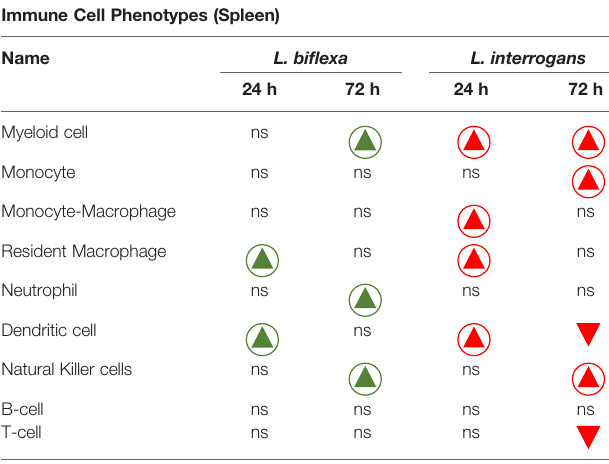
TABLE 3 | Immune cells engaged during infection with pathogenic and non- pathogenic Leptospira at 24h and 72h post-infection in comparison with control. Immune Cell Phenotypes (Spleen)